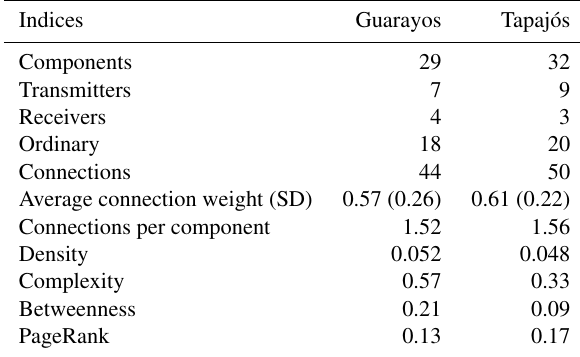
Table 3. Guarayos and Tapajós fuzzy cognitive map indices. Stan- dard deviations shown in brackets and maximum values of the cen- trality